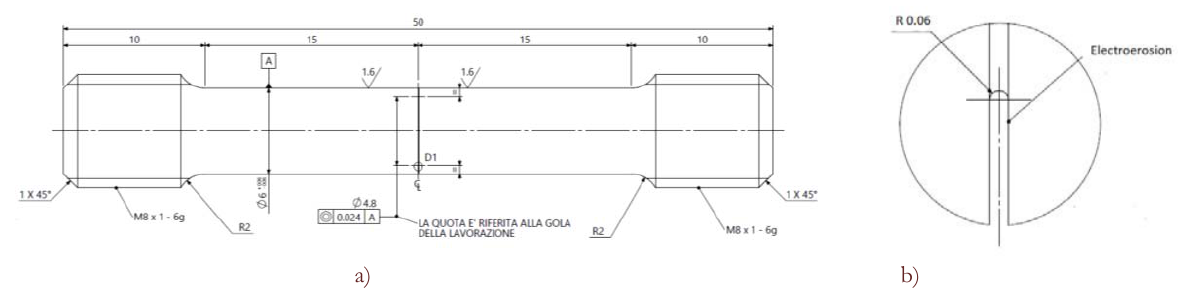
Figure 5: a) CCB dimensions, b) detail of the crack tip.